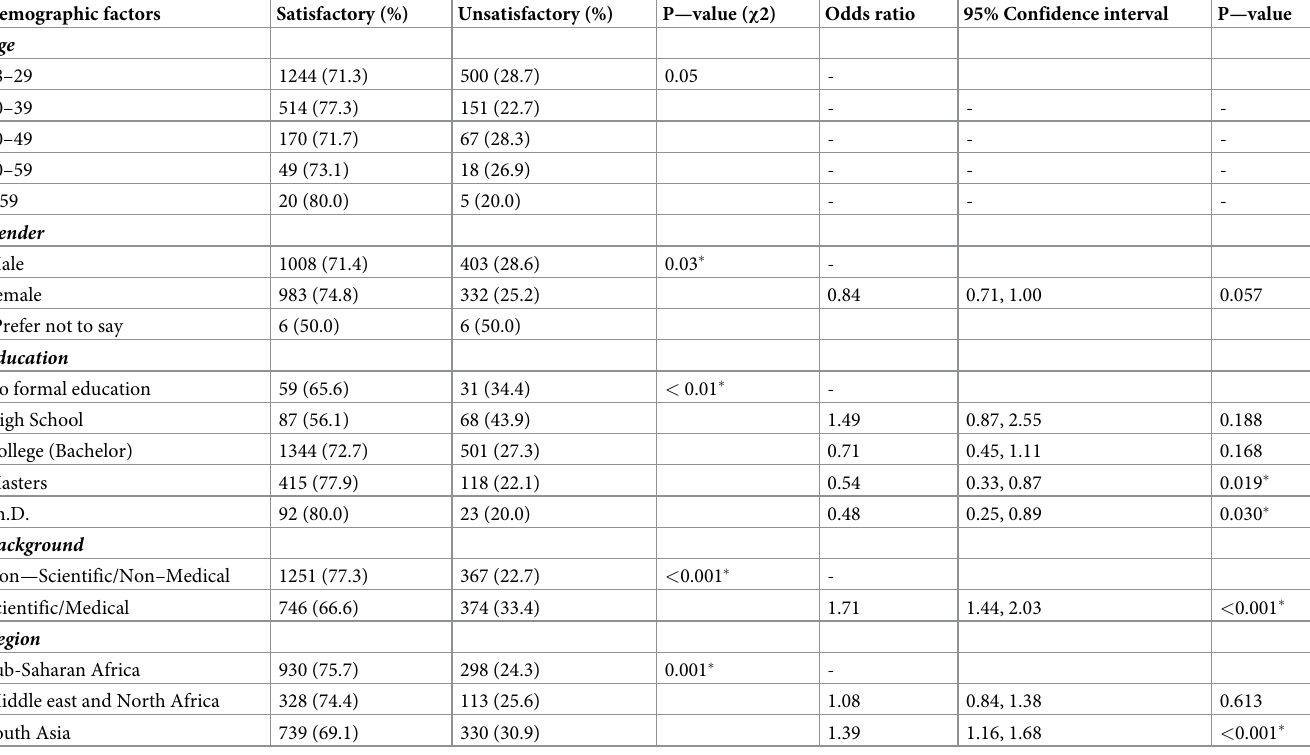
Table 4. Binary logistic regression analysis of demographic factors affecting the knowledge of respondents about COVID-19 pandemic from the three regions.